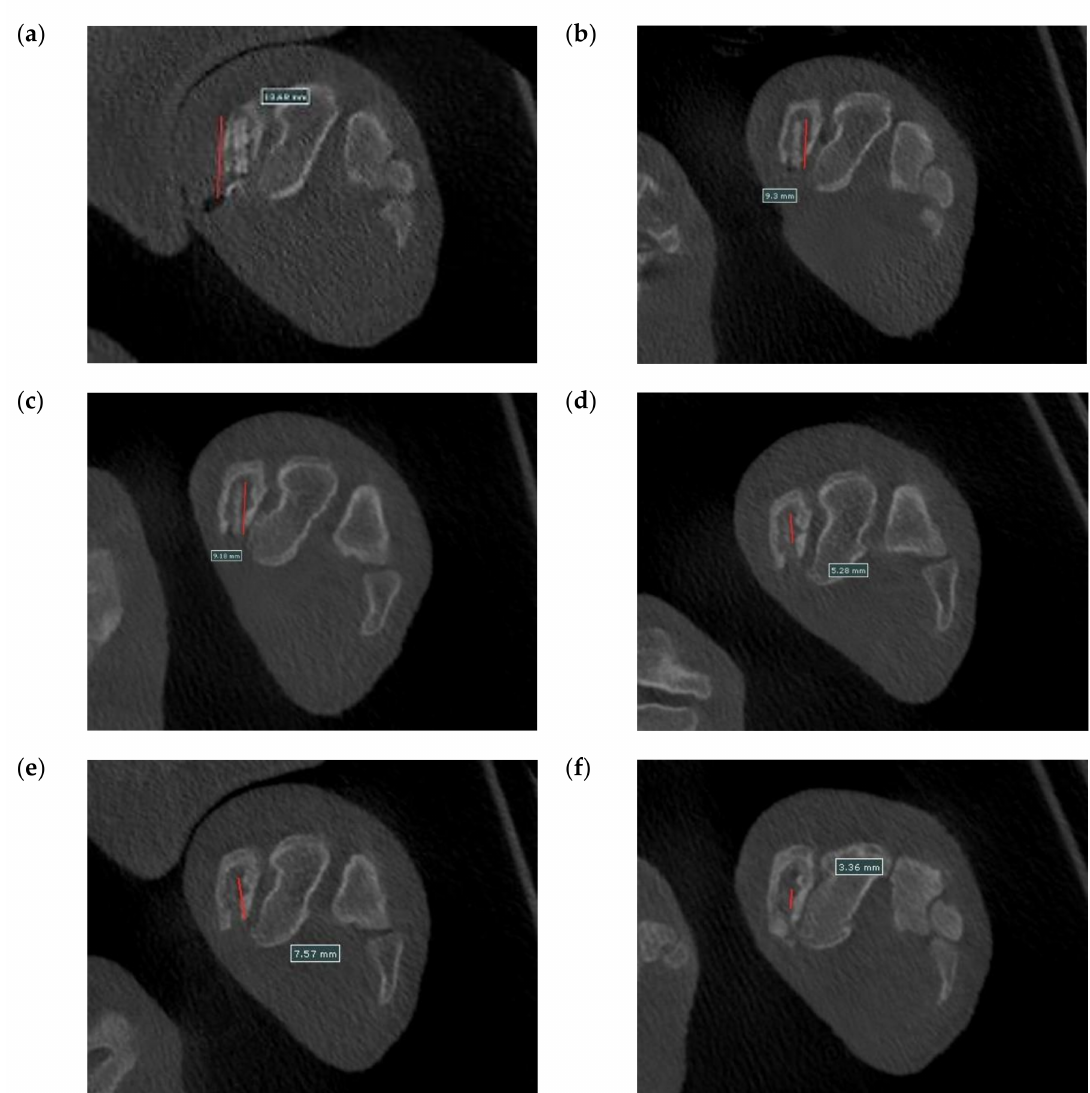
Figure 22. Cross-section CT scans recorded ( a ) 1 month, ( b ) 2 months, ( c ) 3 months, ( d ) 4 months, ( e ) 5 months, and ( f ) 6 months after